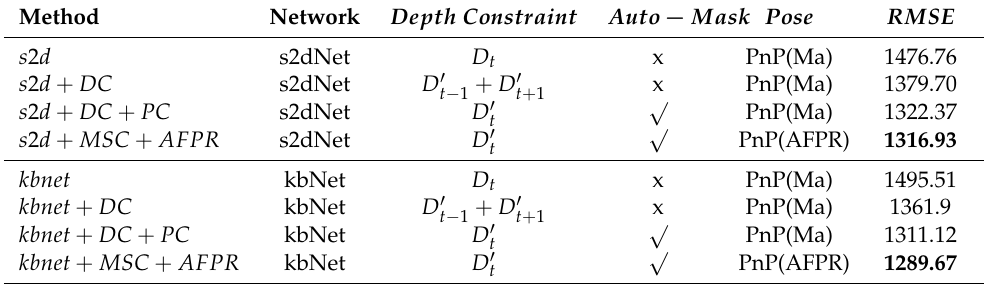
Table 3. Experiment and result comparison of AFPR-PnP algorithms. The bold numbers are the best. Method